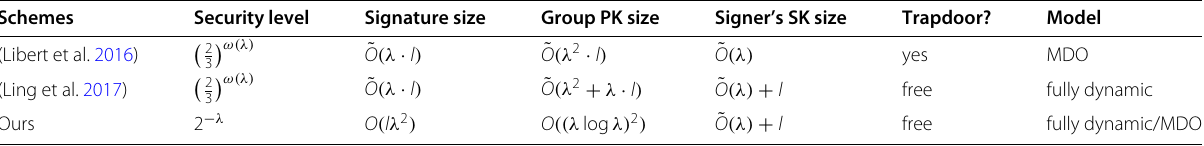
Table 1 Comparison of lattice-based group signature schemes in (Libert et al. 2016) and (Ling et al. 2017), in terms of efficiency and functionality